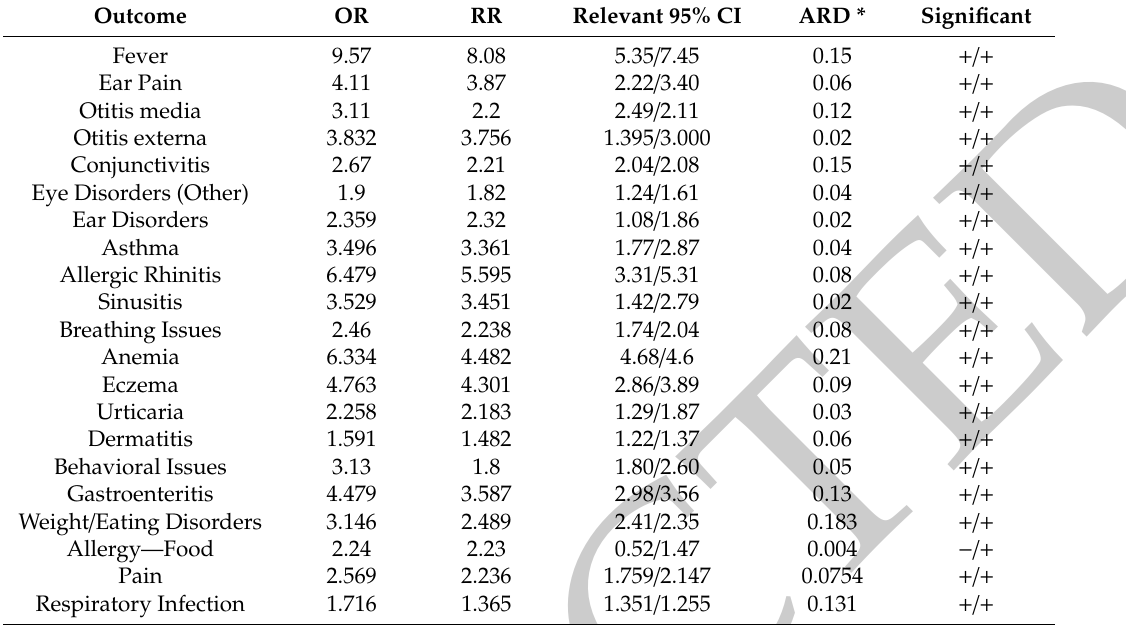
Table 4. Incidence of diagnoses of conditions in the vaccinated vs. unvaccinated groups in the population under